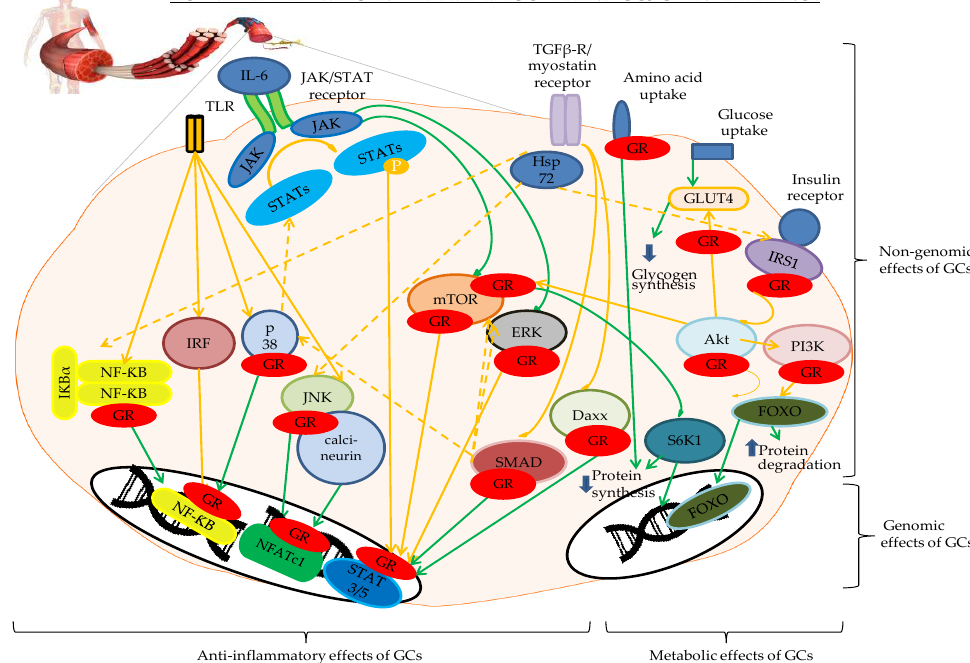
Figure 1. Genomic and non-genomic e ff ects of glucocorticoid receptor (GR) binding to the di ff erent players of the inflammatory and metabolic pathways involved in the Duchenne muscular dystrophy (DMD) myocyte. The pathways indicated in orange are activated, the green indicates a return to the physiological status. The GR is depicted in red. Abbreviations: Daxx = death-associated protein, FOXO = forkhead box O, GLUT4 = glucose transporter 4, GR = glucocorticoid receptor, I κ B = inhibitor of NF- κ B, IRFs = interferon regulatory factors, Hsp72 = heat shock protein 72, IRS1 = insulin receptor substrate 1, JAK / STAT = Janus kinase / signal transducer and activator of transcription proteins, JNK = c-Jun N-terminal kinase, NFATc1 = nuclear translocation of nuclear factor of activated T cells c1, NF- κ B = nuclear factor kappa-light-chain-enhancer of activated B cells, P = phosphorylation, p38 = p38 mitogen-activated protein kinases, PI3K / Akt / mTOR = Phosphoinositide 3-kinases / protein kinase B / mammalian target of rapamycin pathway, RAF / RAS / ERK = Rapidly Accelerated Fibrosarcoma / Ras-extracellular signal-regulated kinase, S6K1 = ribosomal protein S6 kinase beta-1, SMAD3 and -6 = Mothers Against Decapentaplegic homolog 3 and 6, TGF- β = transforming growth factor- β , TLR = Toll-like receptors.